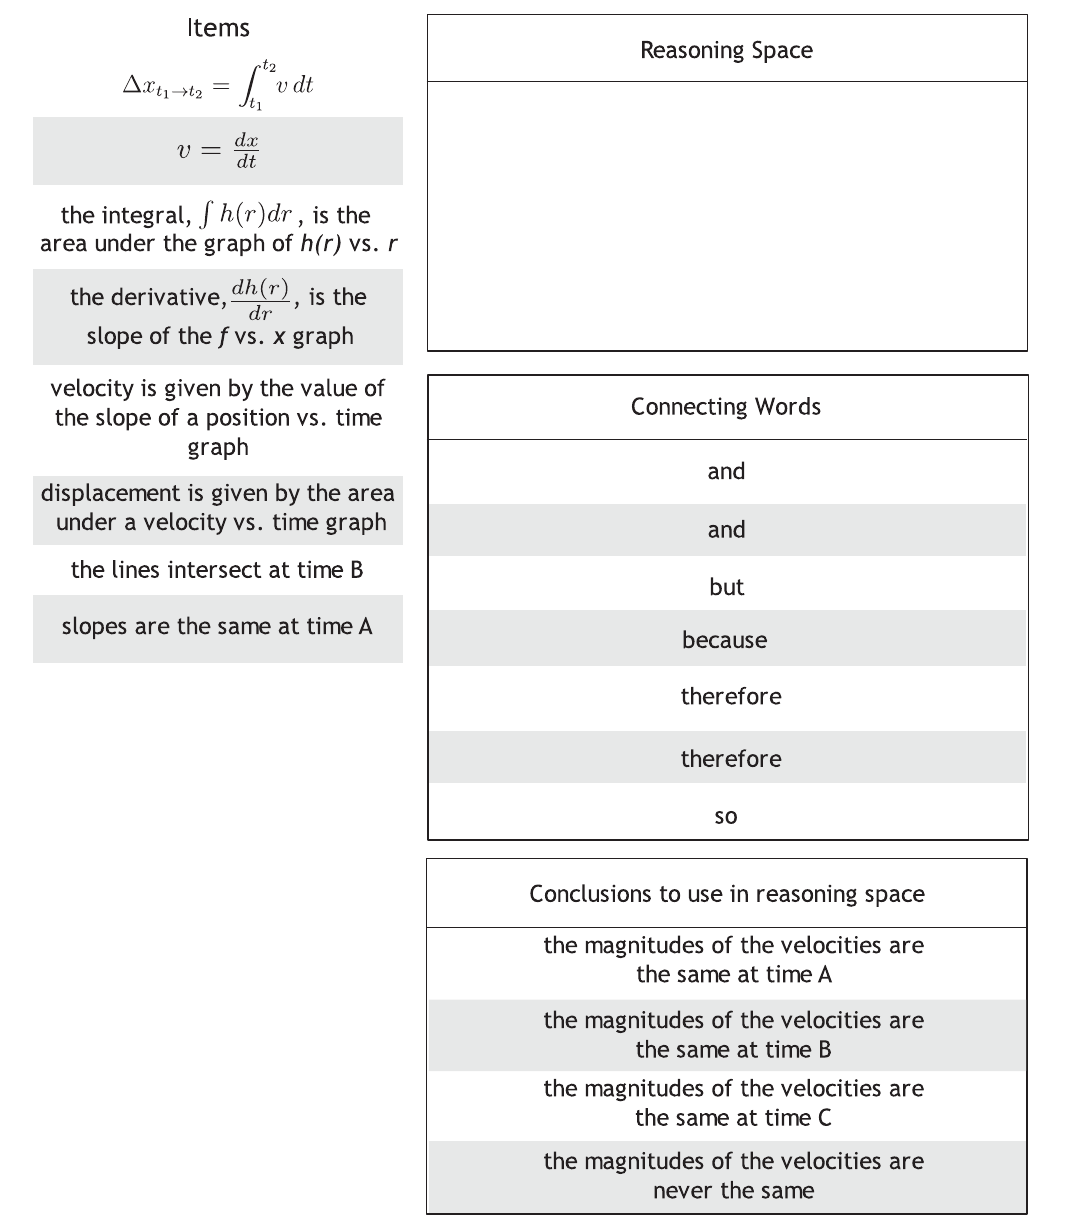
FIG. 4. Example of how a chaining task appears to students online via the Qualtrics platform. Note that the diagram, shown in Fig 1(b), and the question prompt from the kinematics graph task were also provided to